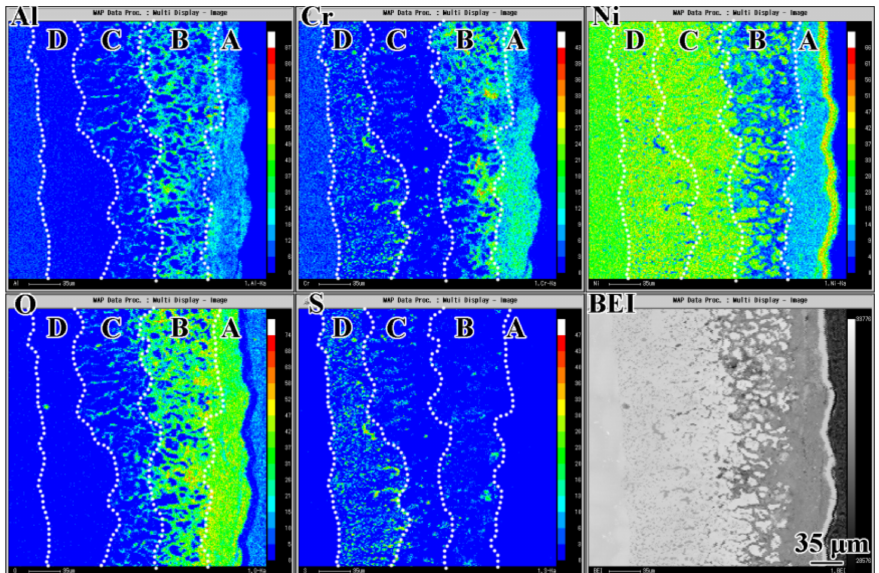
Figure 9. Cross-sectional image and element distribution maps by EPMA for the preoxidised coating after the hot corrosion test lasting 220 h. A zone: a thick, non-protective mixed oxide scale; B zone: consisting of isolated Ni-rich alloy islands and net-like corrosion products; C zone: internal oxidation formed by Al and O; D zone: internal sulphidation formed by Cr and